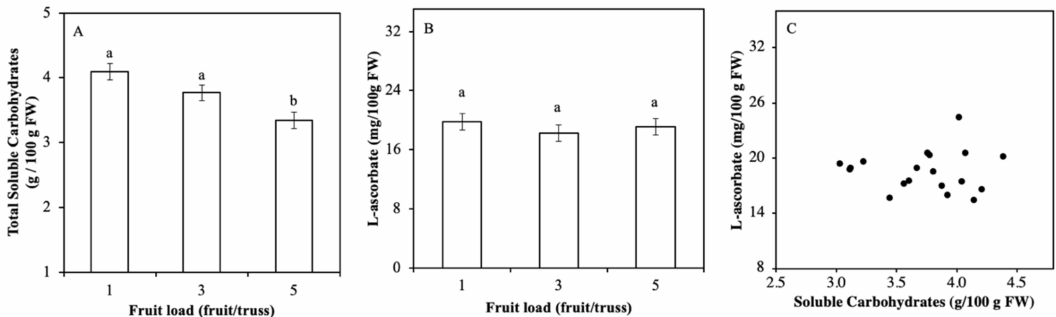
Figure 3. Relation between fruit carbohydrate and ASC levels in mature red tomato fruits grown at 3 di ff erent fruit load levels (1, 3, or 5 fruits per truss). Total soluble carbohydrate content (sum of sucrose, fructose, and glucose) ( A ) and ASC content ( B ). Correlation between ASC and carbohydrate content of individual samples ( C ). Each data point is based on pooled sample of pericarp discs of 2 fruits. Error bars represent standard errors of means, letters indicate statistical di ff erence at α = 0.01; n = 5; Experiment